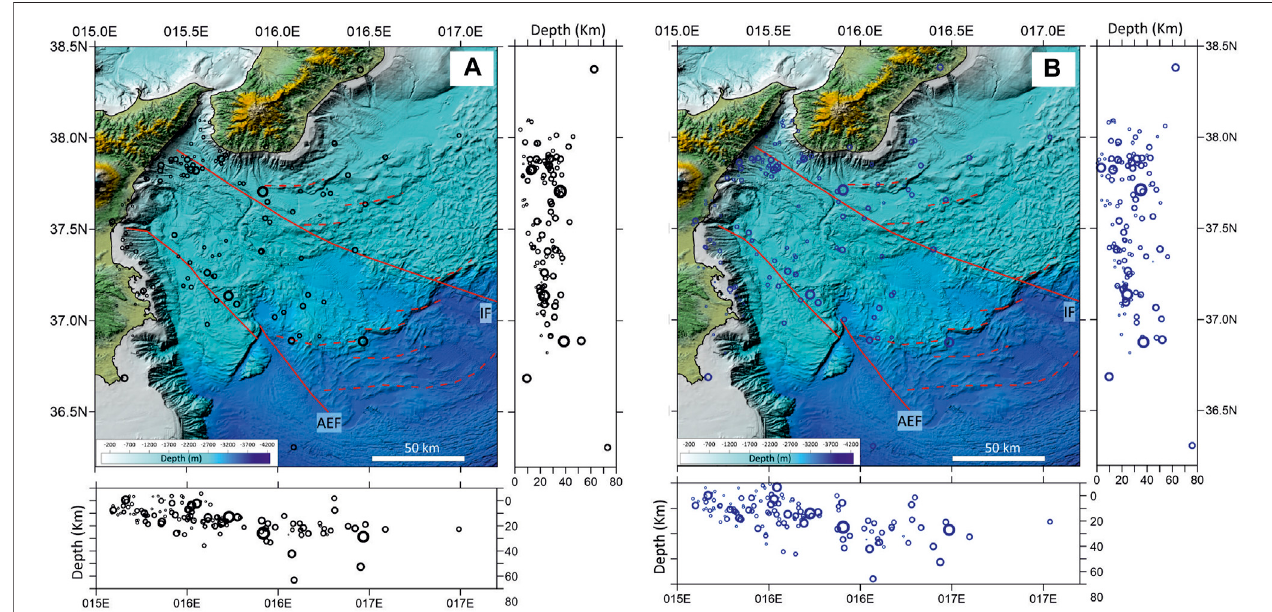
FIGURE 5 | Maps and E-W and N-S sections of 133 earthquake relocations based on a previous 3D velocity model (Sgroi et al., 2021) and computed (A) without OBSstravel-times(blackcircles)and (B) withOBSstravel-times(bluecircles).ThecirclesizesareproportionaltotheM L asreportedonlandseismicbulletin.Parameters oflocationperformedwithandwithouttheuseofOBSsarelisted in SupplementaryTables 1 – 2 .Red linesindicatethepositionofAlfeo-Etnafault(AEF),Ionianfault (IF) and splay faults ( Supplementary Tables 1,2,3 ). Bathymetric map was obtained from high resolution multibeam collected during the oceanographic cruise of SEISMOFAULTS project (Cuffaro et al., 2019; Billi et al., 2020) and merged with DEMs from https://portal.emodnet-bathymetry.eu/.